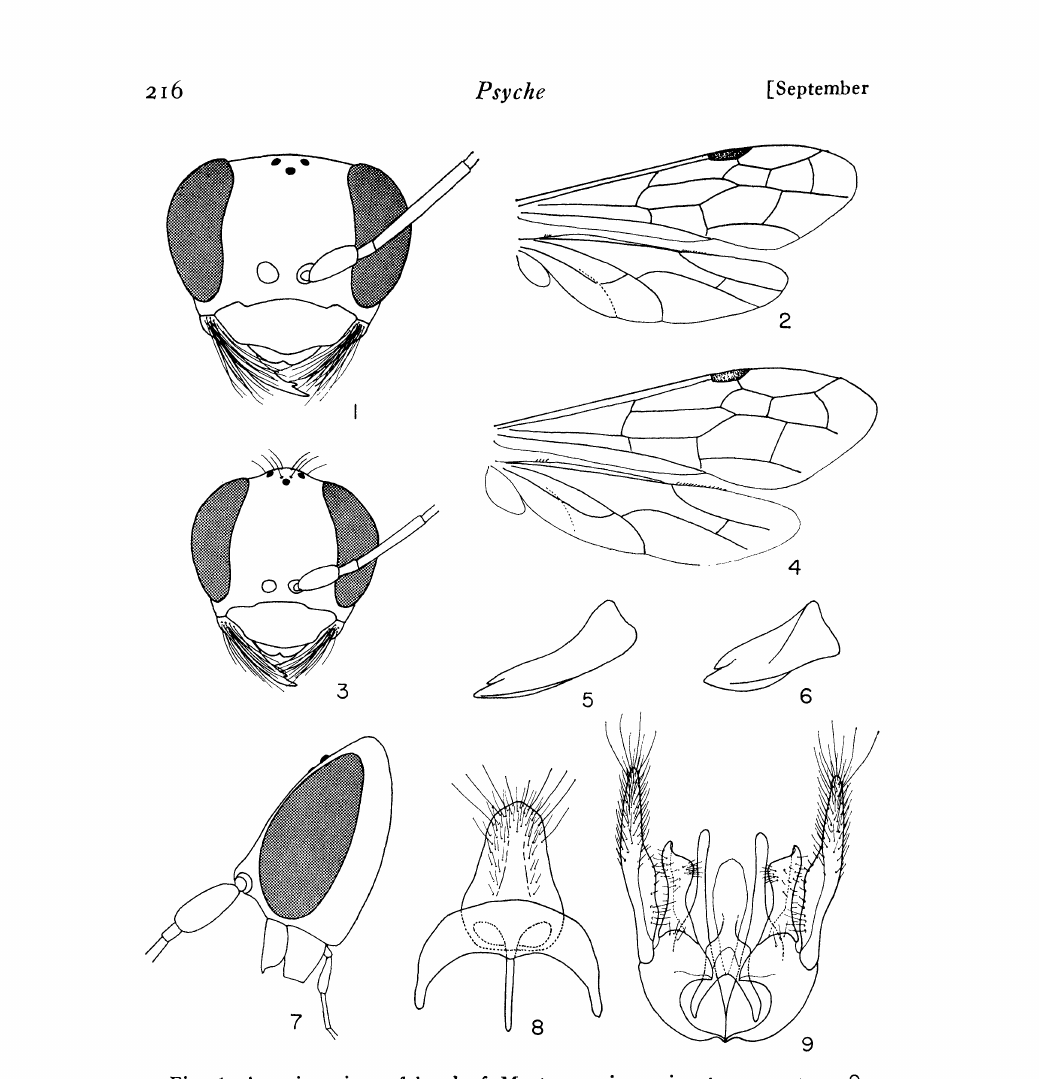
Fig. 1. Anterior view of head of Mystacagenia q:arieyata n. sp., type Fig. 2. Wings of same specimen, color pattern no,t shown. Fig. 3. Anterior view of head of M. albicels n. sp., type Q. Fig. 4. Wings of Dimorha- .aenia naumanni n. sp., allotype 9. Fig. 5. Mandible. of same specimen. Fig 6. Mandible of ./lgeniella (Cyrtagenia) innuba n. sp., type 9. Fig. 7. Lateral view of head of same specimen. Fig. 8. Subgenital plate of Di- morphayenia naumanni n. sp., type 6. Fig. 9. Genitalia of same specimen, ventral